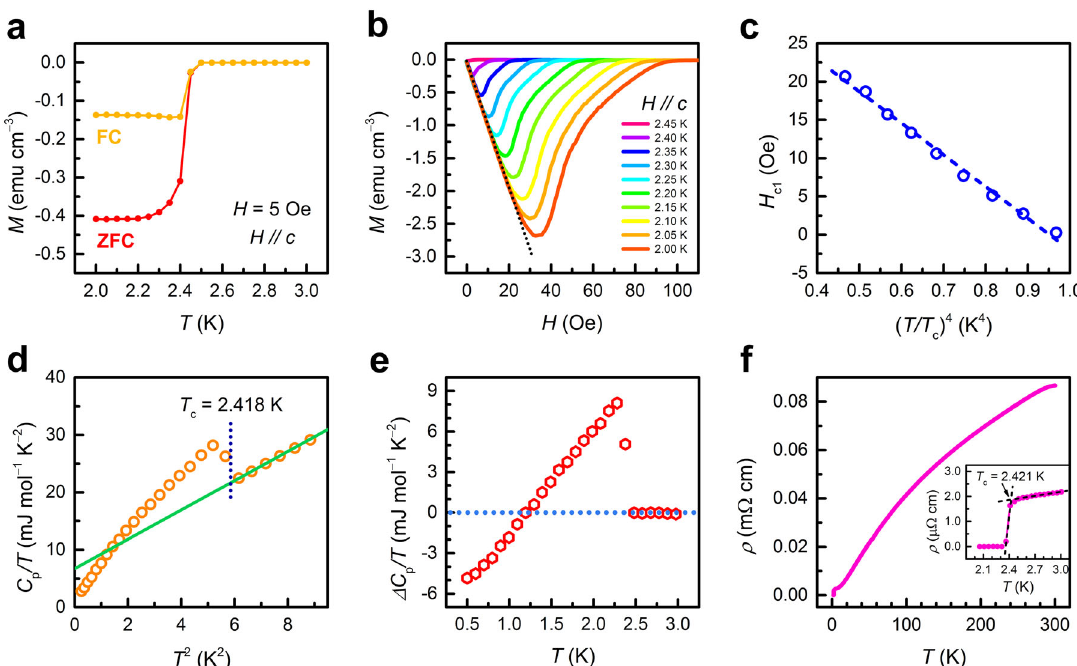
Fig. 2 Magnetic and transport properties of AuSn 4 . a ZFC and FC magnetizations in H = 5 Oe parallel to the crystal c -axis for an AuSn 4 single crystal. b Magnetization M ( H ) curves of AuSn 4 at various temperatures in out-of-plane fi elds. c Obtained H c1 as a function of reduced temperature ( T / T c ) 4 for AuSn 4 with a solid line showing fi t to the data. d Low-temperature heat capacity C p /T vs. T 2 with the red line showing the linear fi t in the temperature range of 2.5 – 3.0 K and the equal-area approximation for the T c determination. e The excess speci fi c heat Δ C p / T of superconductivity by subtracting a smooth normal-state background as represented by the red dashed line. f Whole temperature range of resistivity for AuSn 4 . The inset shows ρ ( T ) in zero fi eld at temperatures near T c